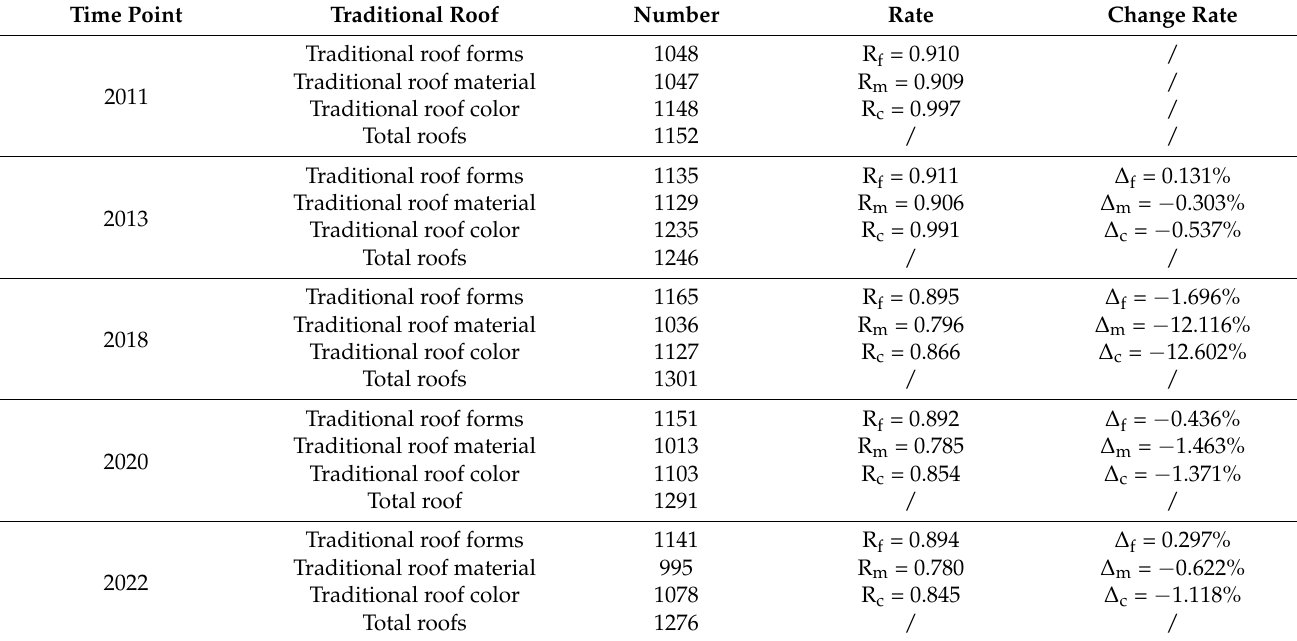
Table 3. The changes in traditional roofs in Lingquan Village at different time